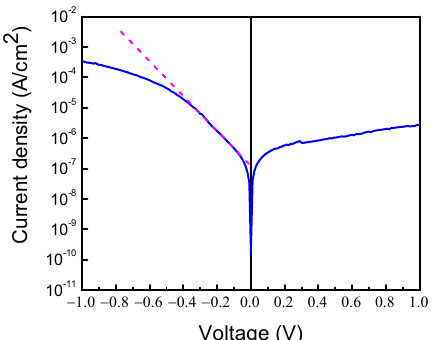
Figure 3. Room temperature I-V characteristic of the sample.